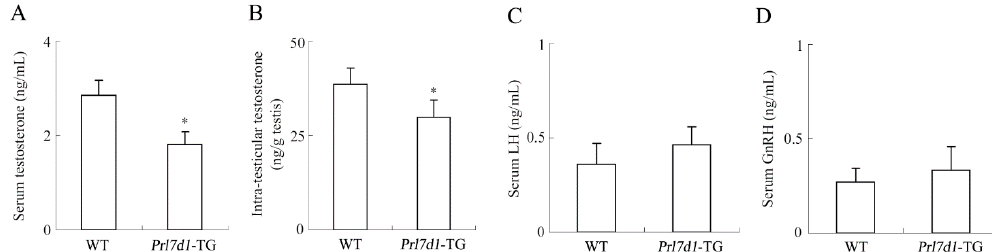
Figure 4. The levels of serum testosterone ( A ), LH ( C ) and GnRH ( D ) and intra-testicular testosterone ( B ) in four-month-old Prl7d1 transgenic ( Prl7d1 -TG) and wild-type (WT) mice. Testosterone, LH and GnRH levels were measured by ELISA. Data are expressed as the means ± SD ( n = 6). * p < 0.01 compared to the WT group.